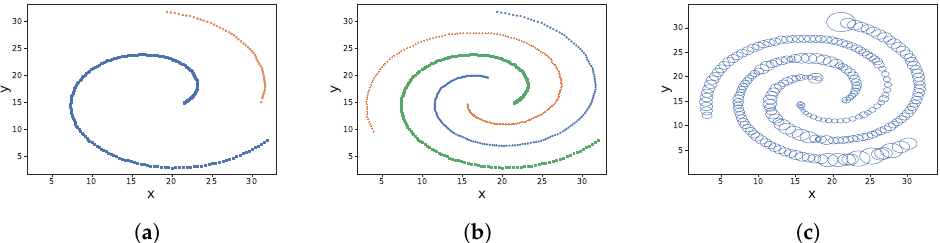
Figure 12. Clustering of the Three Spirals dataset with Macro SOStream. ( a ) Clustering of the first 261 samples forming two distinct macroclusters, represented by different colors. ( b ) Final result with three macroclusters. ( c ) Representation of the